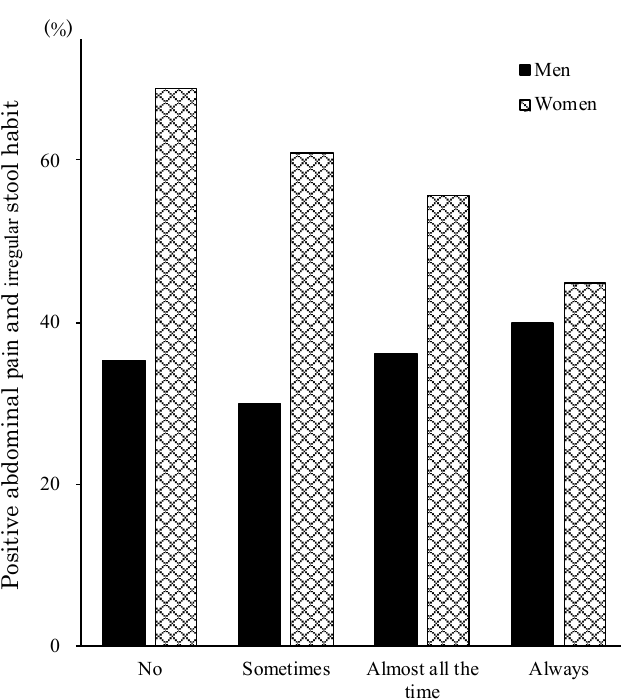
Figure 2. A positive LGIP was more prevalent in women who cooked less, whereas there were no differences in terms of cooking habits in men .